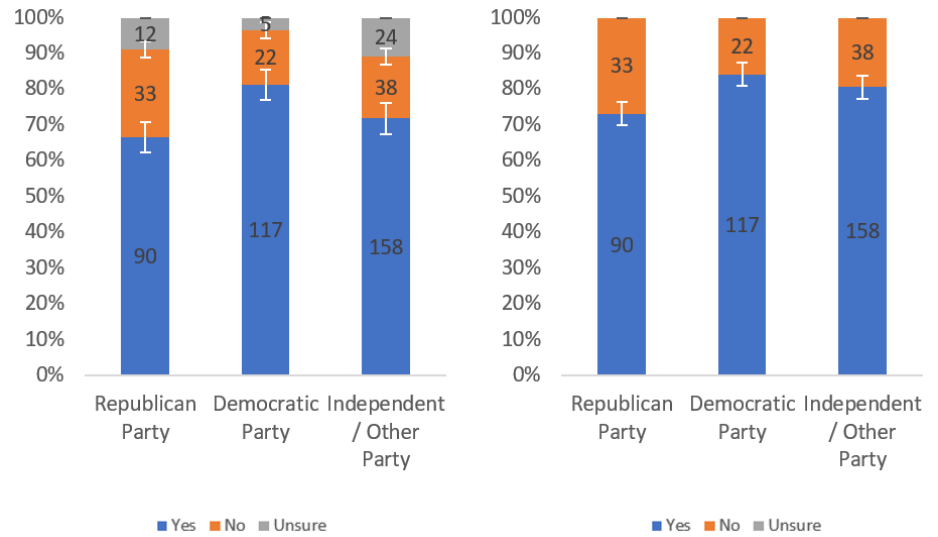
Figure 8. Responses regarding label helpfulness by political affiliation including ( left ) and excluding ( right ) unsure responses.